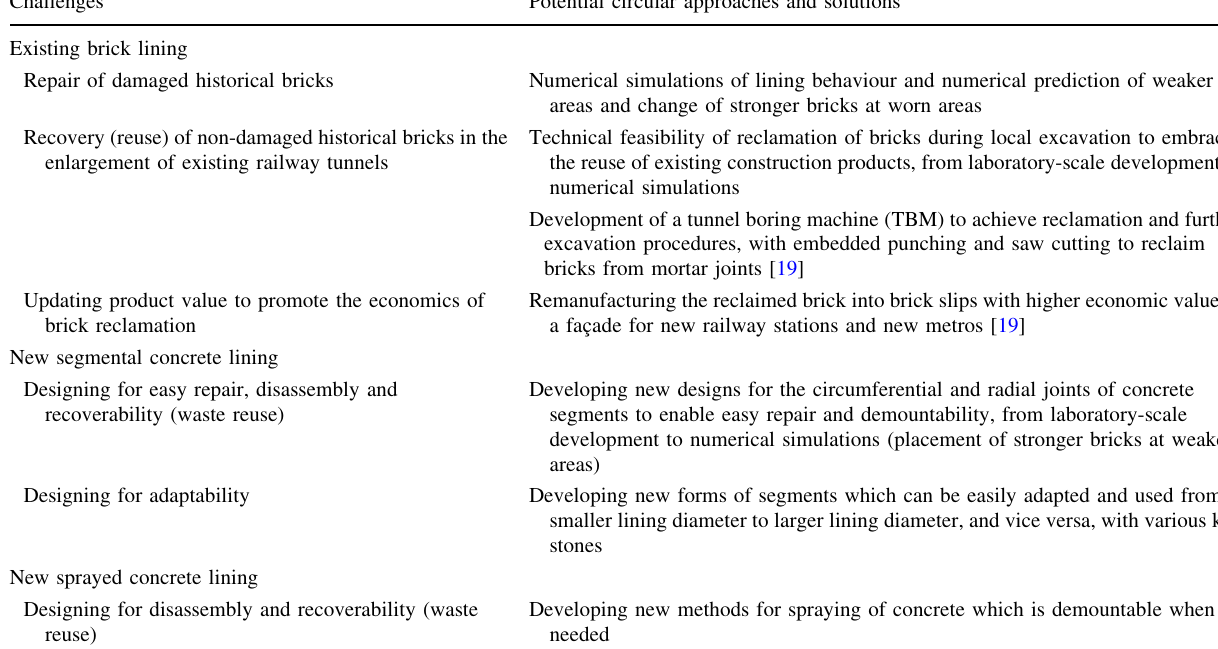
Table 1 Summary of circular approaches and solutions for underground infrastructures Challenges Potential circular approaches and solutions Existing brick lining Repair of damaged historical